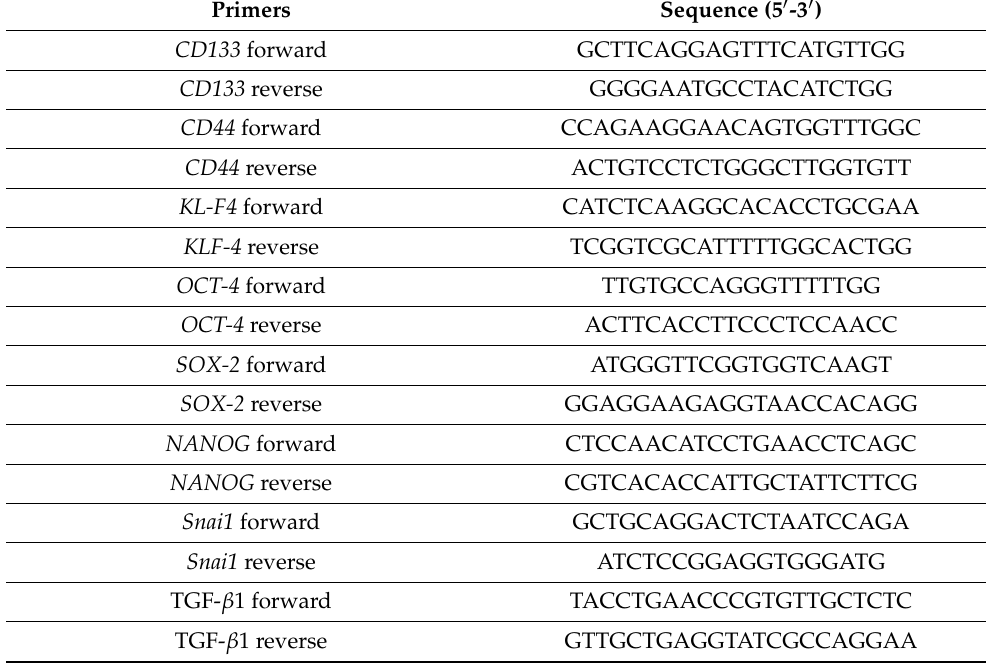
Table 1. List of primers for